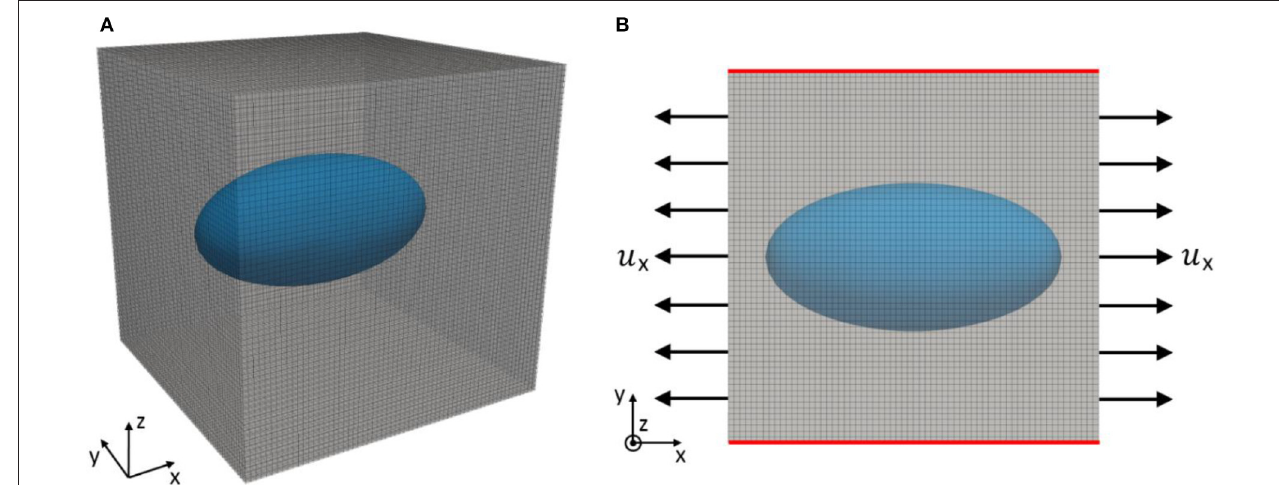
FIGURE 7 | Three-dimensional view (A) and projection onto xy -plane (B) of RVE with ellipsoidal inclusion discretized with N 3 d el = 262144 8-noded hexahedral finite elements. The ellipsoidal inclusion (blue) is located in the center of the RVE and surrounded by a matrix (gray). To probe the stiffness of the RVE in x -direction, a uniform displacement u x is imposed on the faces in positive and negative x -direction (arrows) while on all the other faces (red) a uniform displacement field perpendicular to the faces with zero average traction in outer-normal direction is